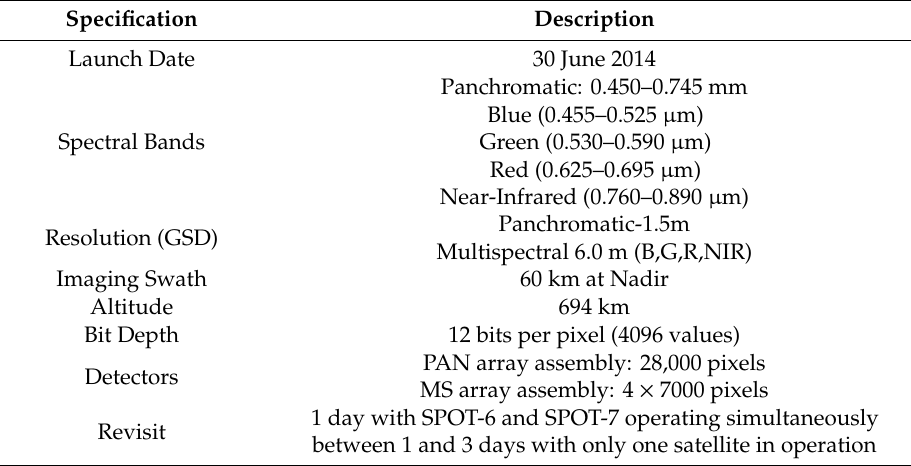
Table 4. SPOT-7 satellite sensor